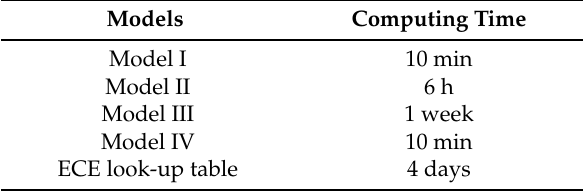
Table 3. Comparison of approximate computing times in different models.